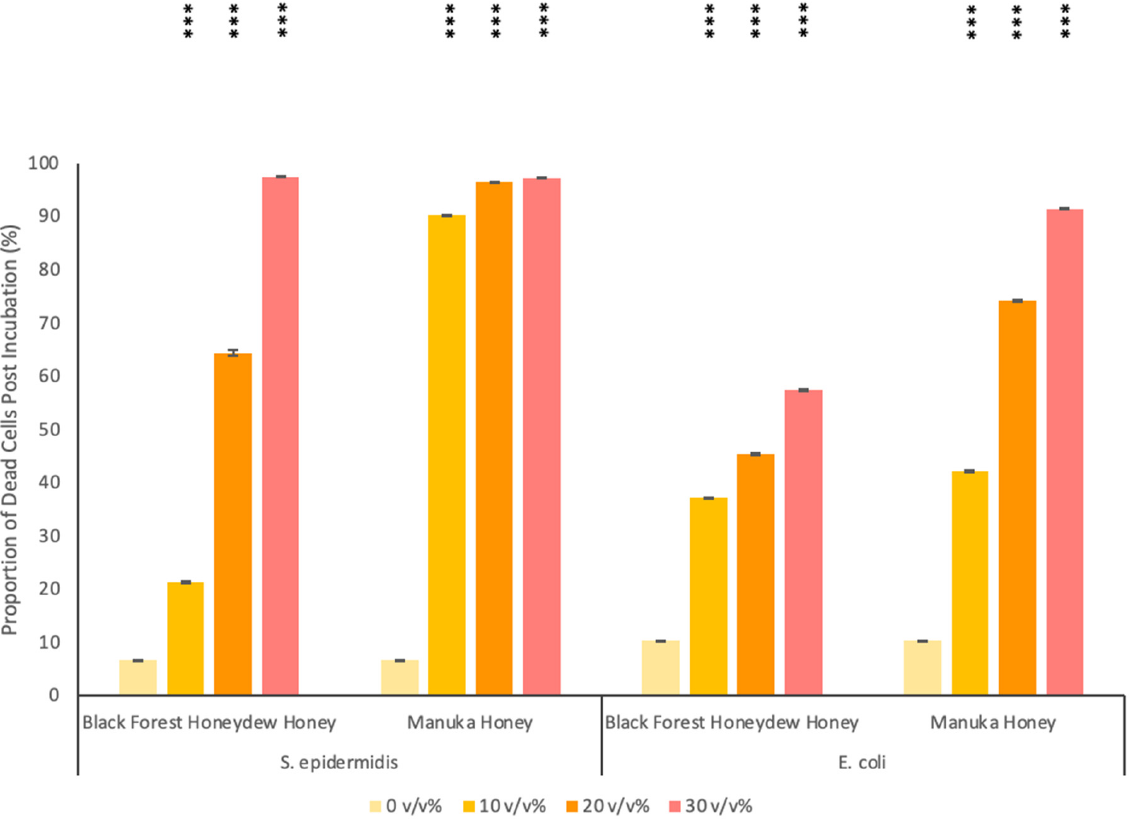
Figure 4. Antibacterial activity of S. epidermis and E. coli against Black Forest honeydew and manuka honey at concentrations of 10, 20 and 30 ( v / v %). The antibacterial efficiency is given here as the percentage proportion of dead cells following incubation. p values of < 0.001 (***) when compared to the control are shown on the graph.